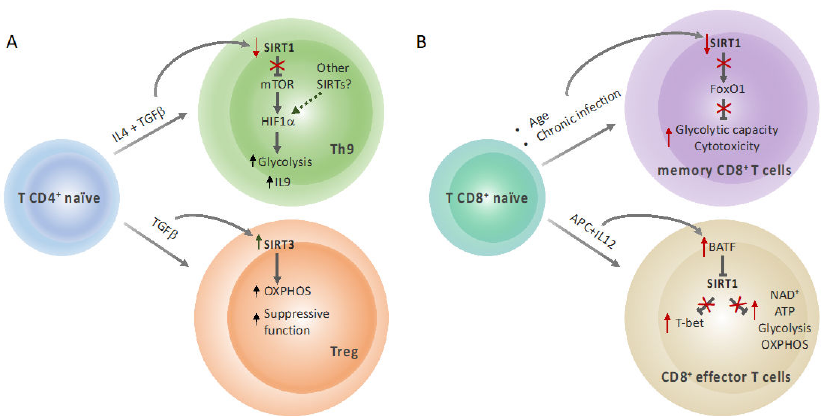
Figure 2. Sirtuins link T cell metabolism and differentiation. ( A ) Differentiation of T CD4+ naïve cell (in blue) into Th9 cells (in green) is accompanied by a decrease in SIRT1 expression, releas- ing its inhibitory action on the mTOR/HIF1 α axis and leading to an increase in aerobic glycoly- sis and IL9 expression. Differentiation into Treg cells (in orange) is associated with an increase in SIRT3 expression and oxidative phosphorylation, which supports their suppressive function. ( B ) Accumulation of resting memory CD8+ T cells (in violet) during aging or chronic infection is linked to a decrease in SIRT1 expression and the concomitant upregulation of glycolysis. Epigenetic silencing of SIRT1 expression by BATF also drives metabolic changes associated with effector CD8+ T cell differentiation (in beige). Red arrows indicate upregulation (up arrows) or downregulation (down arrows) induced by indicated stimuli. Red “X” indicate block of the depicted pathway regulated by